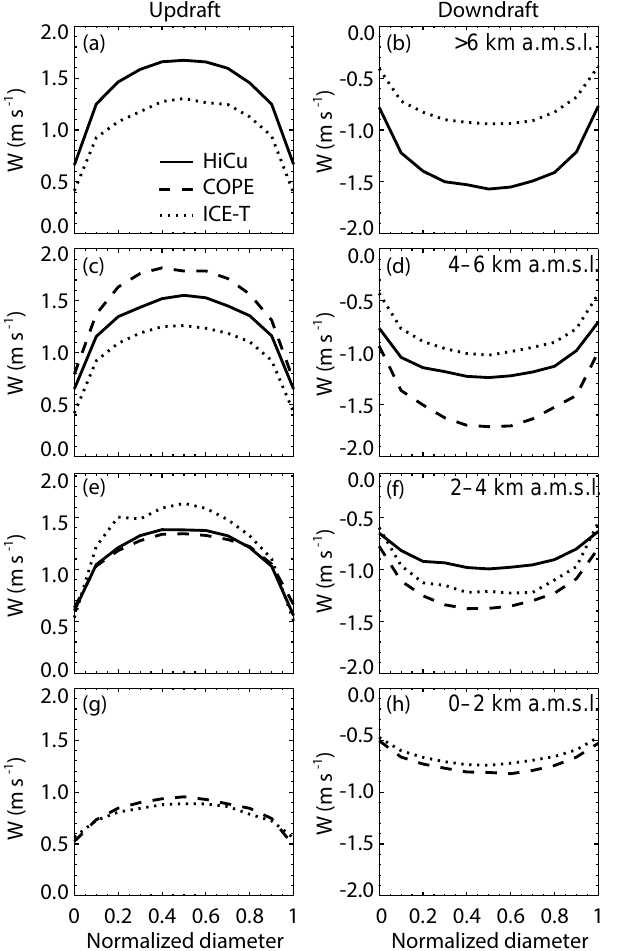
Figure 11. Composite structure of the vertical velocity as a function of the normalized diameter for the updrafts and downdrafts with air mass flux ≥ 10kgm − 1 s − 1 in magnitude. The 0 and 1 coordinates on the x axis indicate the upwind and downwind sides of the draft.